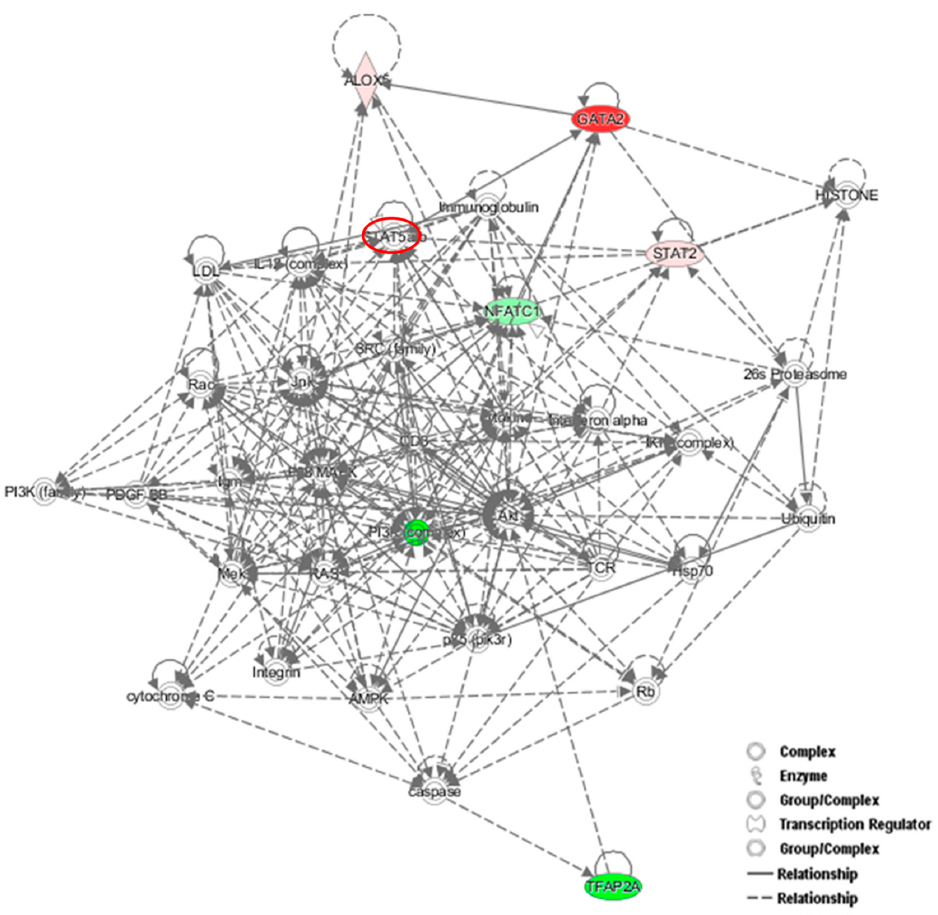
Figure 6. Protein network analysis using Ingenuity Pathway Analysis (IPA). Proteins identified in the dataset are highlighted in red or in green when they exhibit a higher or a lower content in NFATc1-knockdown cells compared to untransfected cells. The intensity of the node color indicates the expression level or degree of regulation. Genes in uncolored notes were not differentially expressed in our experiment and were integrated into the computationally generated networks based on the evidence stored in the IPA knowledge memory, which indicated relevance to this